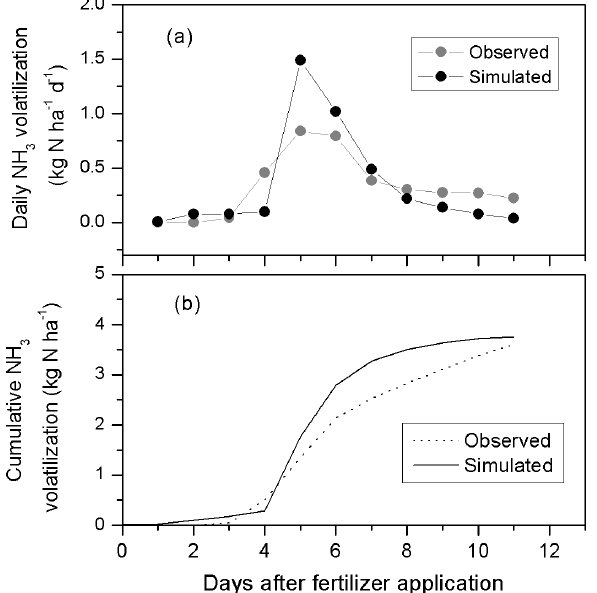
Fig. 4. Observed and simulated daily (a) and cumulative (b) am- monium volatilization due to one fertilizer application event in the wheat–maize field during July of 2008. The Observed data were adapted from Yang et al. (2011).